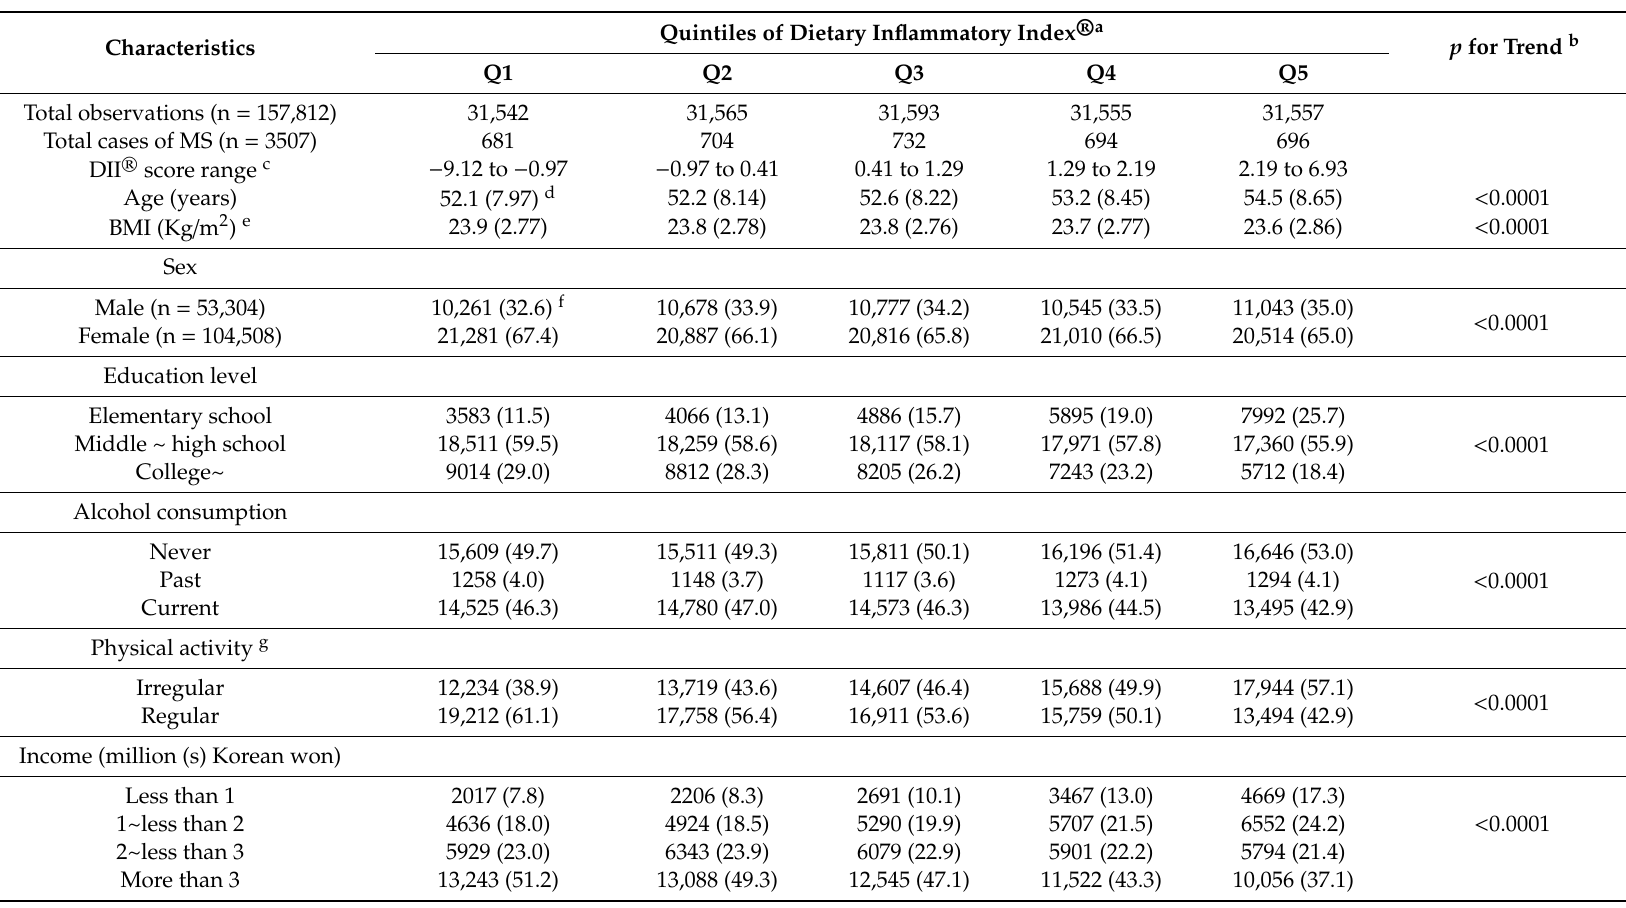
Table 1. Baseline characteristics of the study participants by Dietary Inflammatory Index ® (DII ® ) quintiles in the KoGES_HEXA cohort, 2004–2013.